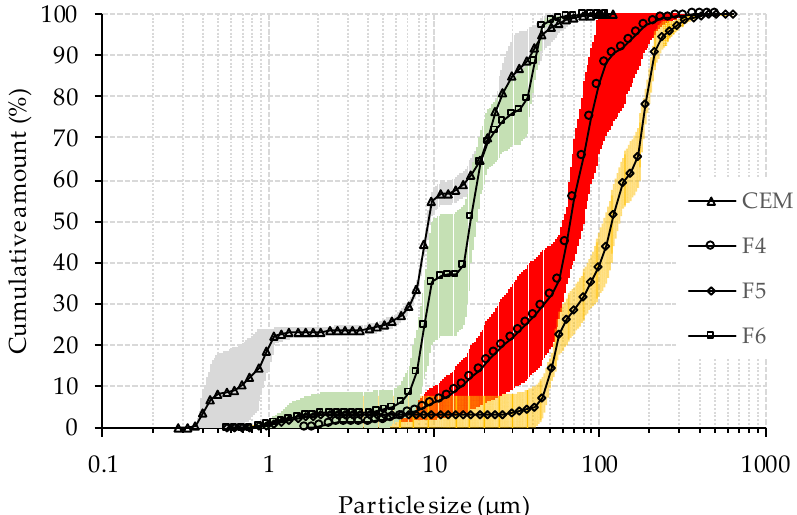
Figure 2. Particle size distribution of cement and WFA (shaded area represents standard deviation).